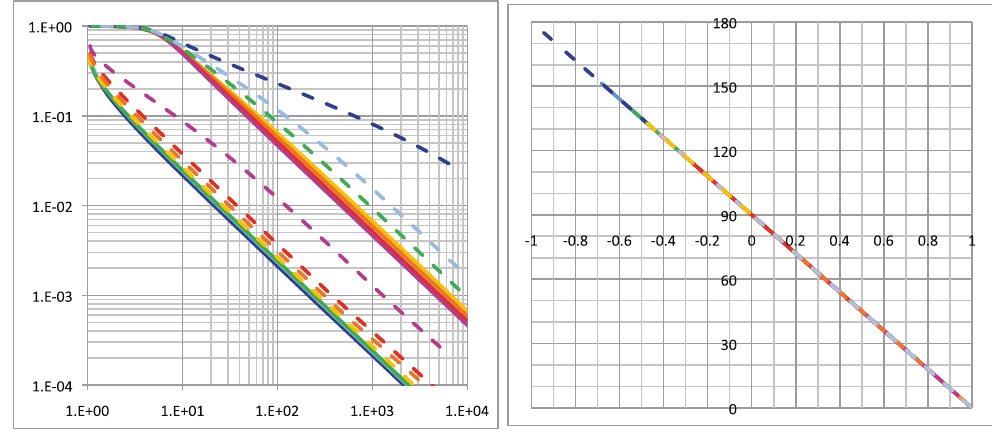
Fig. 3 Macroscopic contact angle versus dimensionless drop size L and dimensionless number characterizing the contact angle W θ . a Relative macroscopic contact angle ϑ versus dimensionless drop size L ; ( b ) Macroscopic contact angle versus dimensionless contact angle W θ . W θ ¼ (cid:1) 0 : 99 (blue), − 2/3 (cyan), − 1/3 (green), 0 (yellow), 1/3 (orange), 2/3 (red) and 0.99 (magenta). The solid (dashed) lines represent the plots for positive (negative) S = l σ